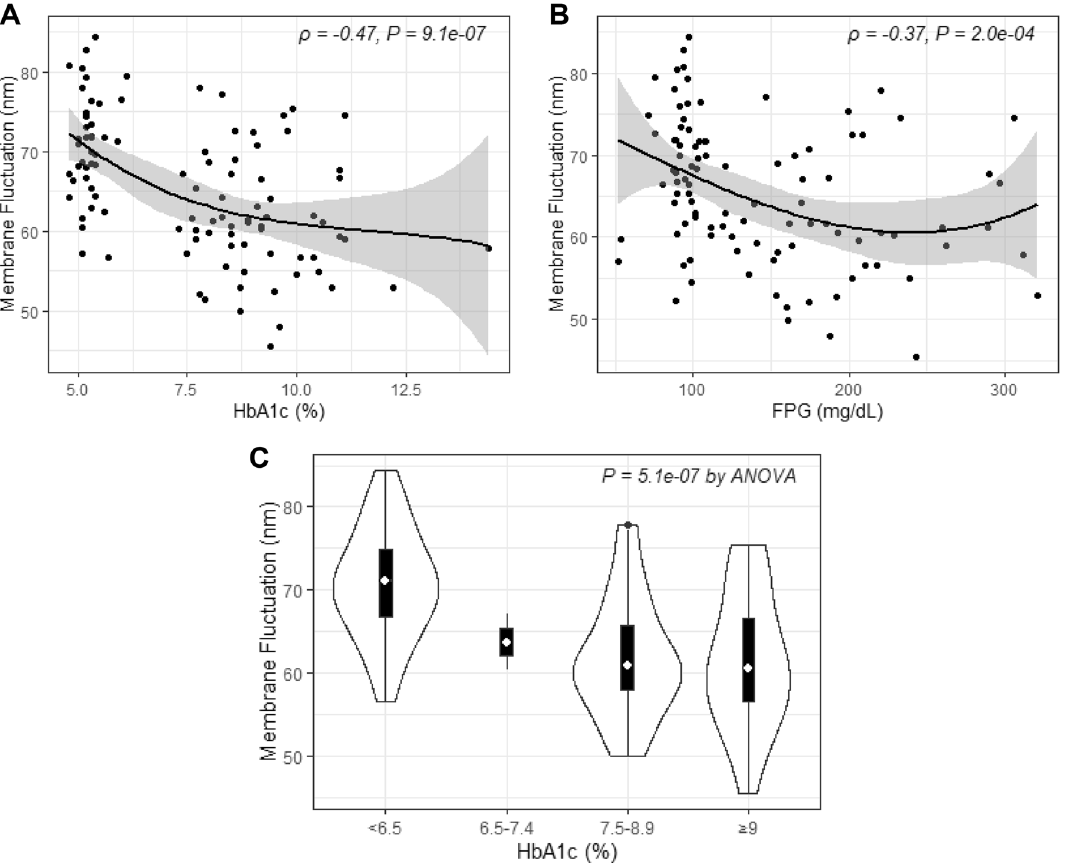
Figure 1. Correlations between the membrane fluctuations of red blood cells and clinical factors. ( A ) HbA1c (%), ( B ) FPG, fasting plasma glucose (mg/dL), ( C ) Groups divided by HbA1c levels as follows: < 6.5%, 6.5%– 7.4%, 7.5%–8.9%, and ≥ 9%.